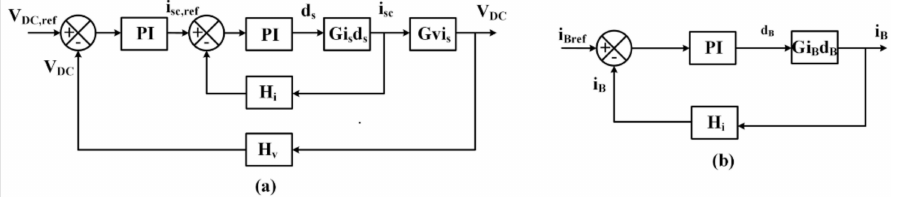
Figure 7. Overall block diagram: ( a ) representation of supercapacitor control logic and ( b ) represen- tation of battery control